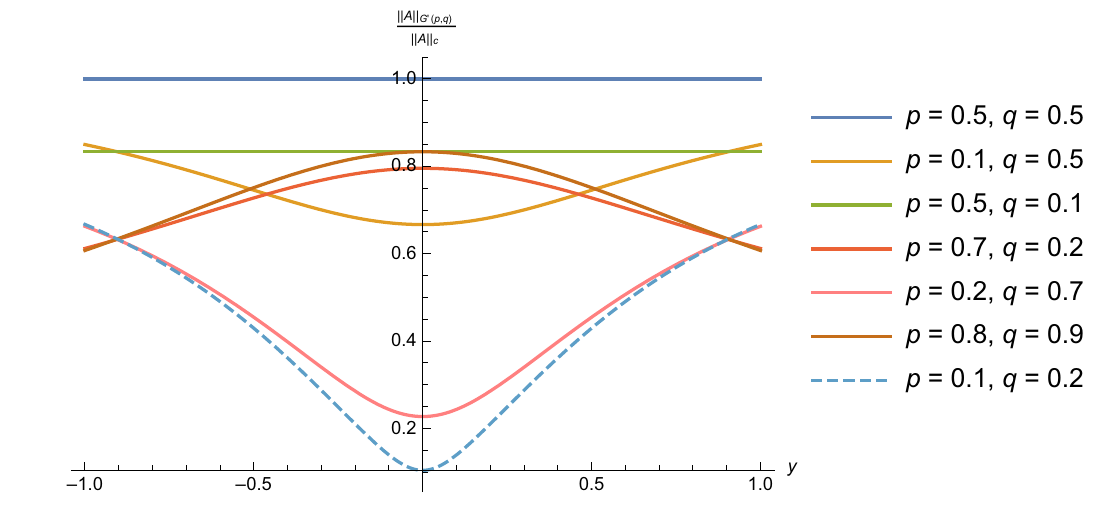
FIG. 9. The ratio (cid:2) A (cid:2) G (cid:17) ( p , q ) / (cid:2) A (cid:2) c for y ∈ [ − 1, 1] and different values of p and q